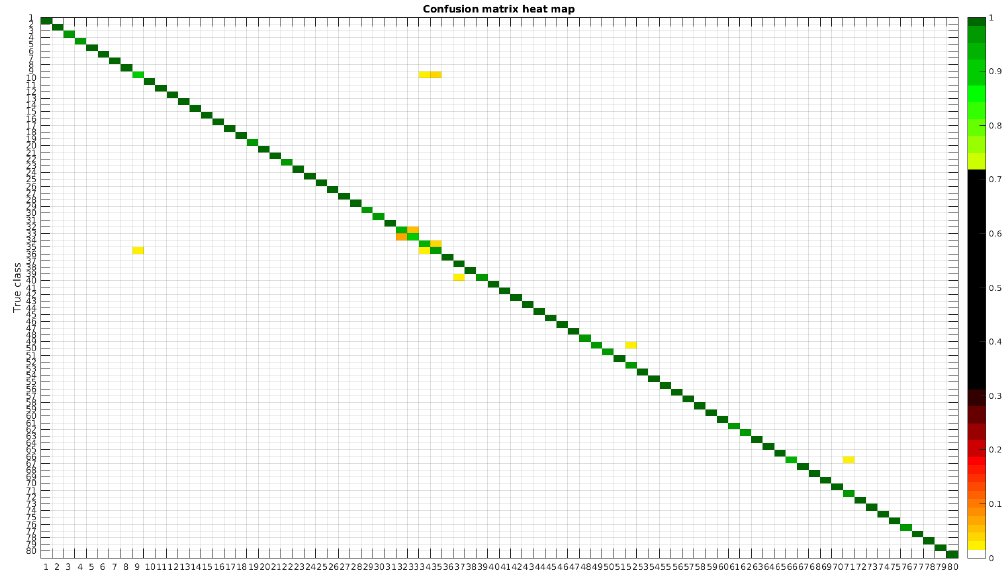
Figure 6. Confusion matrix heat map for the original dataset with 700 samples per class.